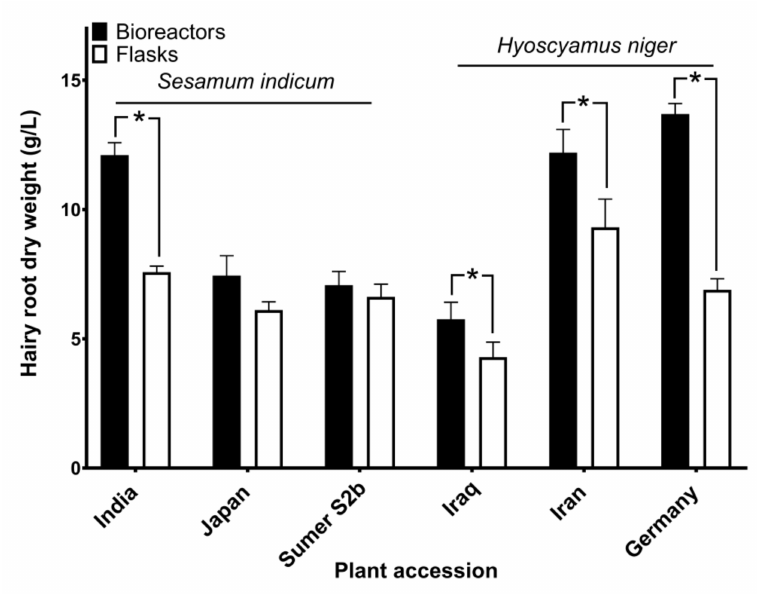
Figure 7. Biomass of hairy roots grown in bioreactors and flask cultures. Hairy root cultures originating from three accessions of each plant species were grown for 30 days and the dry weight of harvested biomass was determined. Asterisks denote significant di ff erences between means (two-tailed t -test, n = 3, p < 0.05).